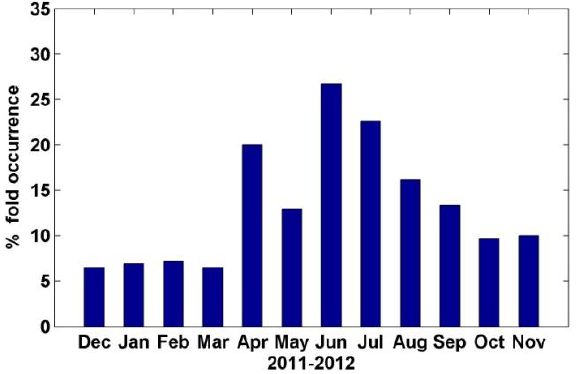
Fig. 5. Percentage fold occurrence at Troll station between Decem- ber 2011 and November